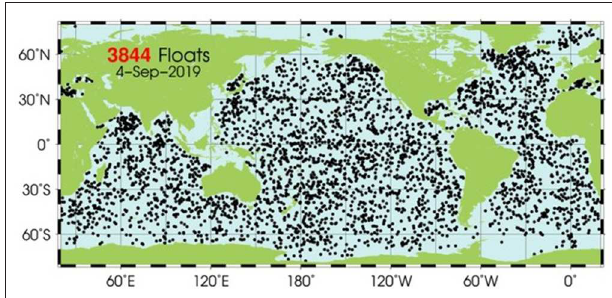
FIGURE 5 | Coverage of the global ocean by Argo floats on 04 September 2019.